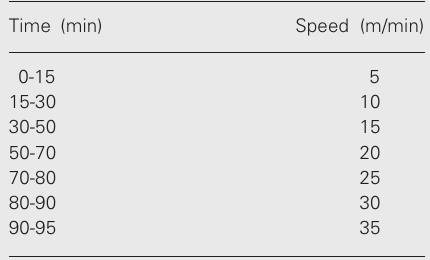
Table 1. Protocol of exhaustive physical exercise.